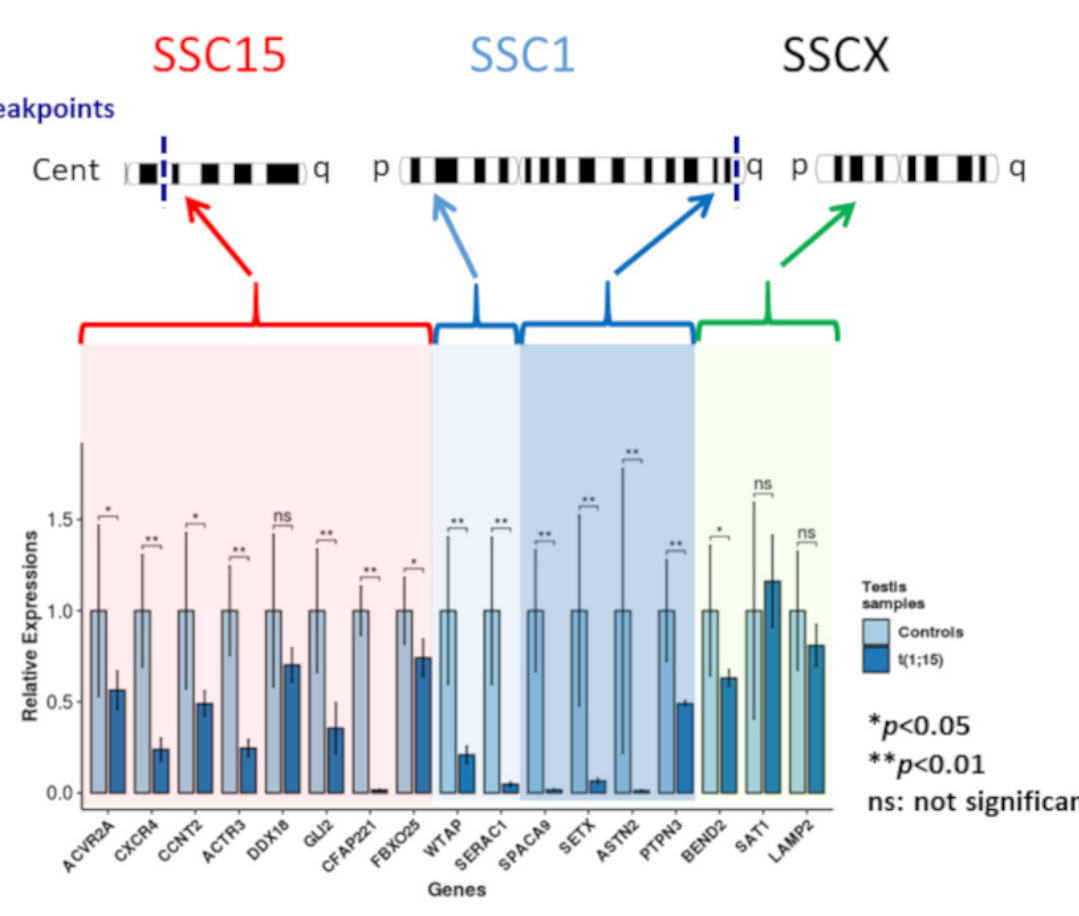
Figure 4. Gene expression analysis.